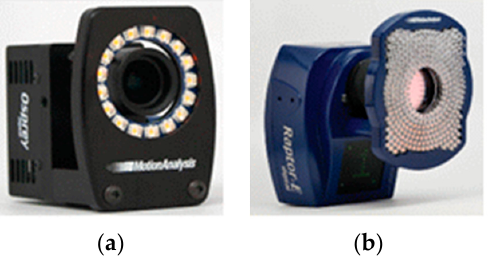
Figure 1. Configuration of motion capture system (infrared cameras): ( a ) Oespery; ( b ) Raptor-E.